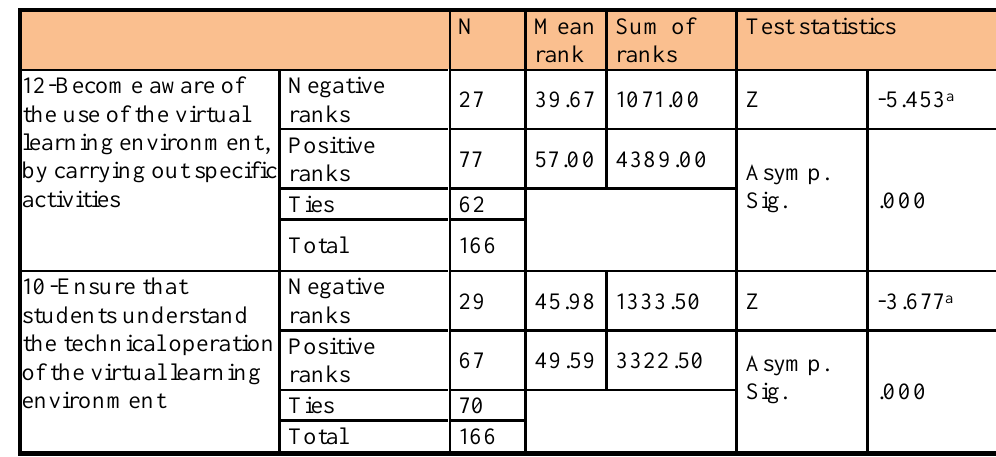
Wilcoxon Signed Ranks Test. Median Difference on the Level Of Proficiency and Professional Development Needs Regarding the Technological Role Competencies Applied to Online